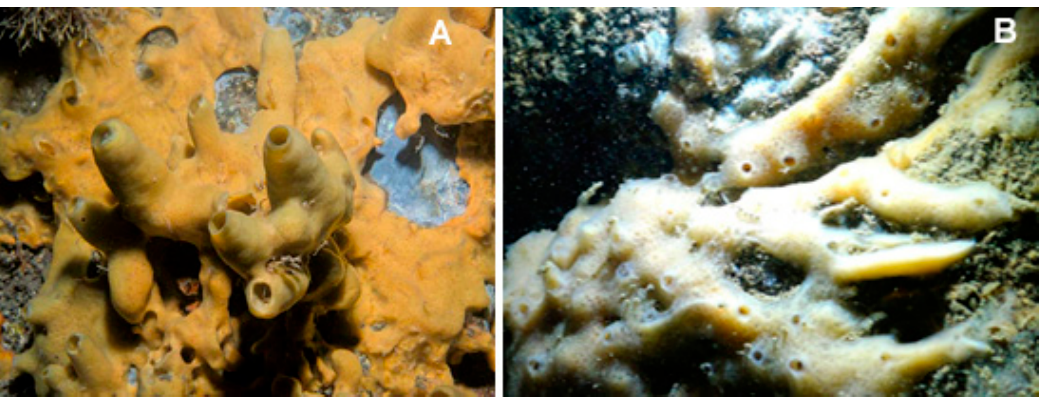
Figure 10. Two examples of species of the genus Halichondria . ( A ) Halichondria panicea (Pallas, 1766), taken from [60]. ( B ) Halichondria bowerbanki (Burton, 1930), taken from [61].